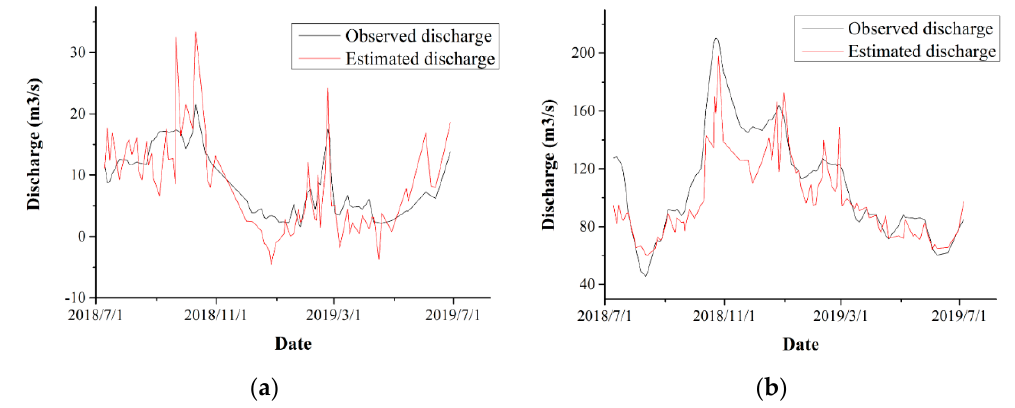
Figure 6. Temporal pattern of C / M-based discharge and observed discharge in validation year. ( a ) Gauge 410130, ( b ) Gauge 414200. Table 2. Accuracy of discharge estimation for two test gauges in validation year.